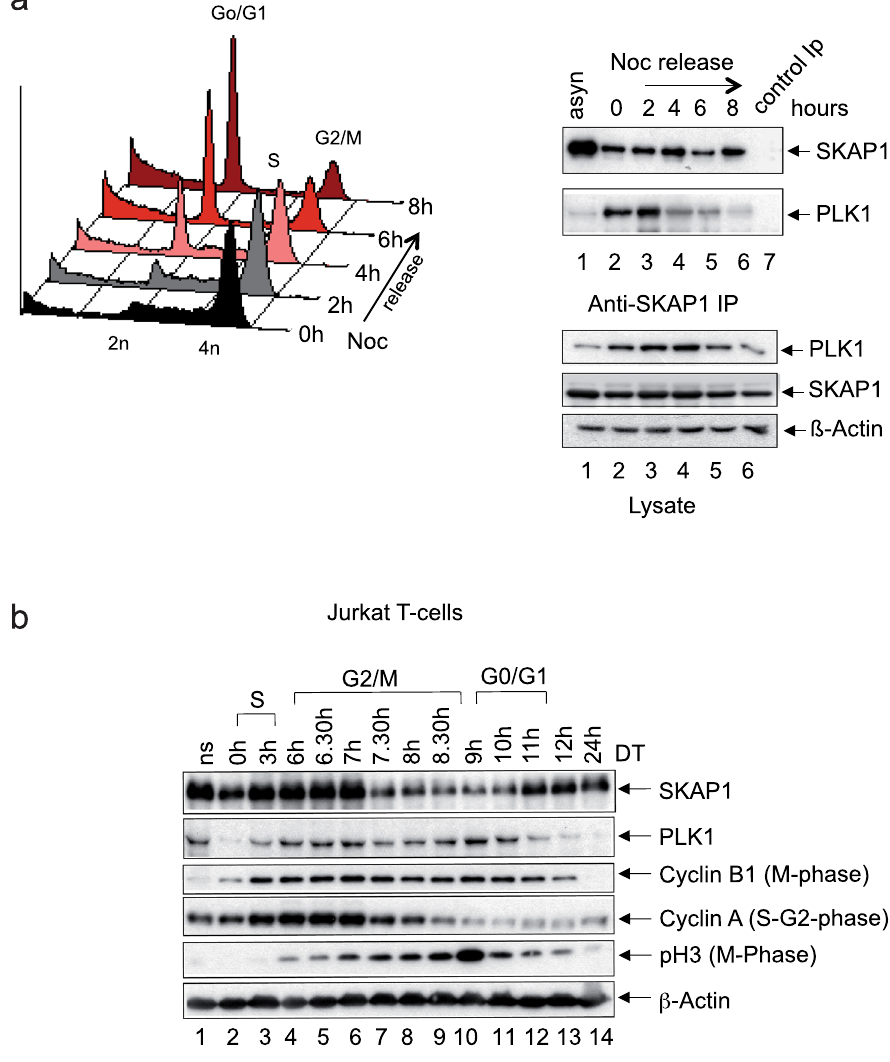
Figure 6. Interaction of SKAP1 and PLK1 is regulated following arrested mitosis. (Panel a) Jurkat T-cells were incubated with 150 nM nocodazole for 16 hours and released in fresh media for 8 hours and analyzed by FACS and Western blotting. Mitotic arrested cells at 0 hour showed a 4N status in G2/M (left panel). Washing the cells and their release from blockade was followed by the progression to 2N in G0/G1 over 2–8 hours. Right panel: Anti-SKAP1 co-precipitation of PLK1 with SKAP1 following release from mitotic arrest. Lower panels: Blotting of cell lysates with anti-PLK1, SKAP1 and β -Actin. (Panel b) Jurkat cells were synchronized by double thymidine treatment and analyzed by Western blotting with antibodies against SKAP1, PLK1, Cyclin B1, Cyclin A, pHistone, H3 and β